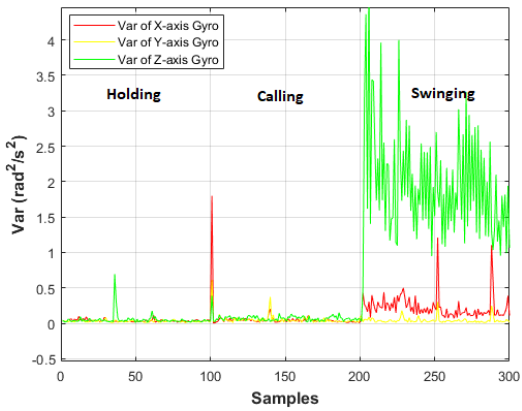
Figure 12. The variances of angular velocities with three smartphone modes while the pedestrian is